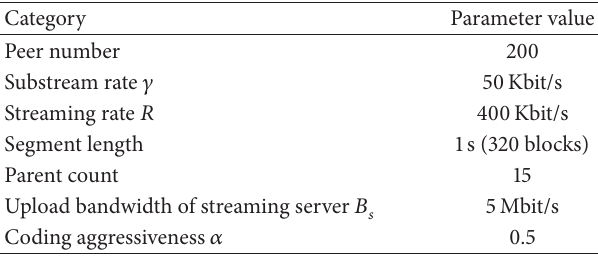
Table 2: The default parameters of the simulation.